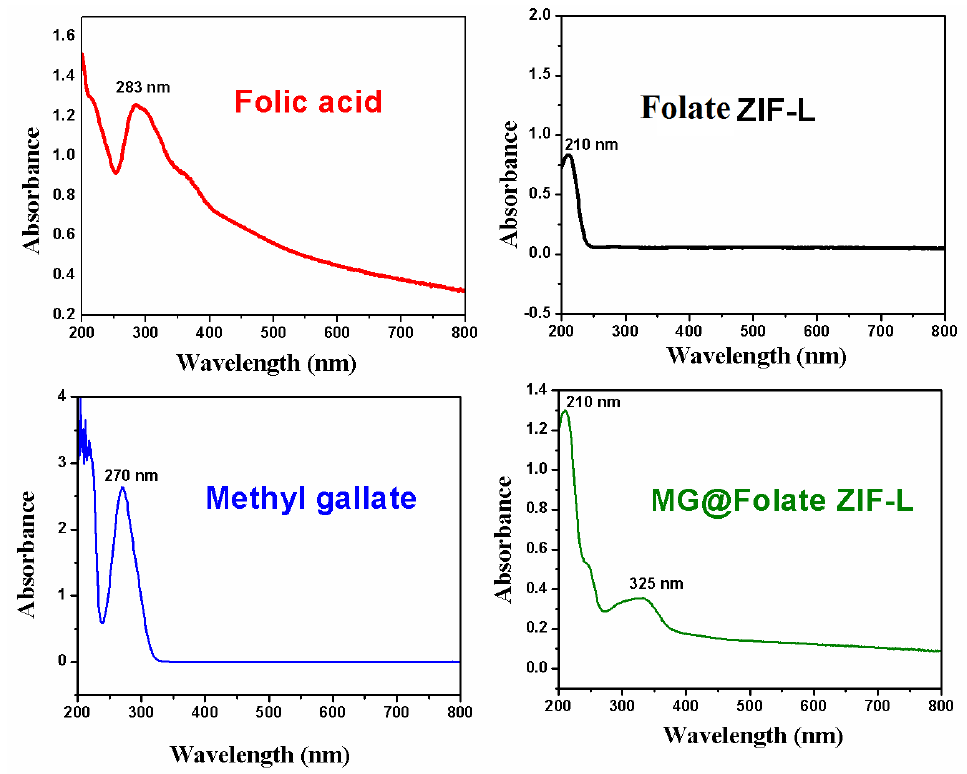
Figure 1. UV-Vis spectrum of folic acid (red) Folate ZIF-L (black), MG@Folate ZIF-L (green), methyl gallate (blue).